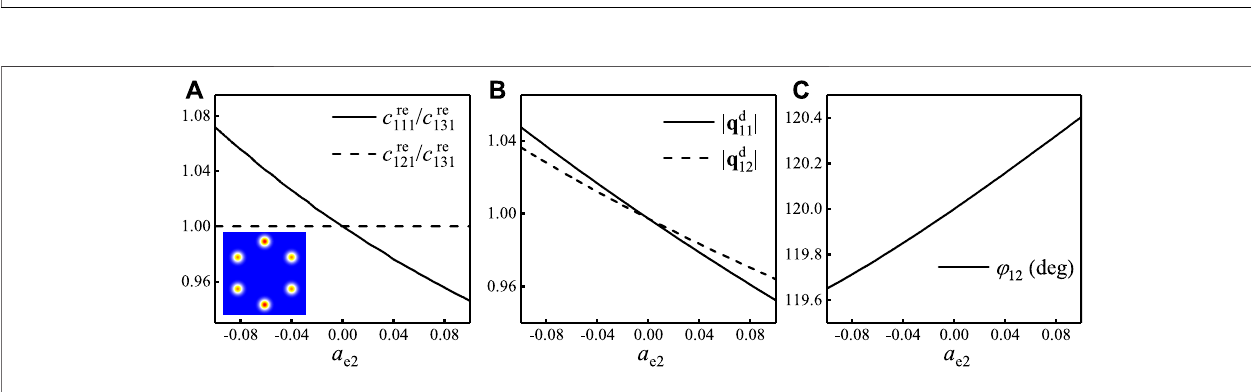
Frontiers in Physics |